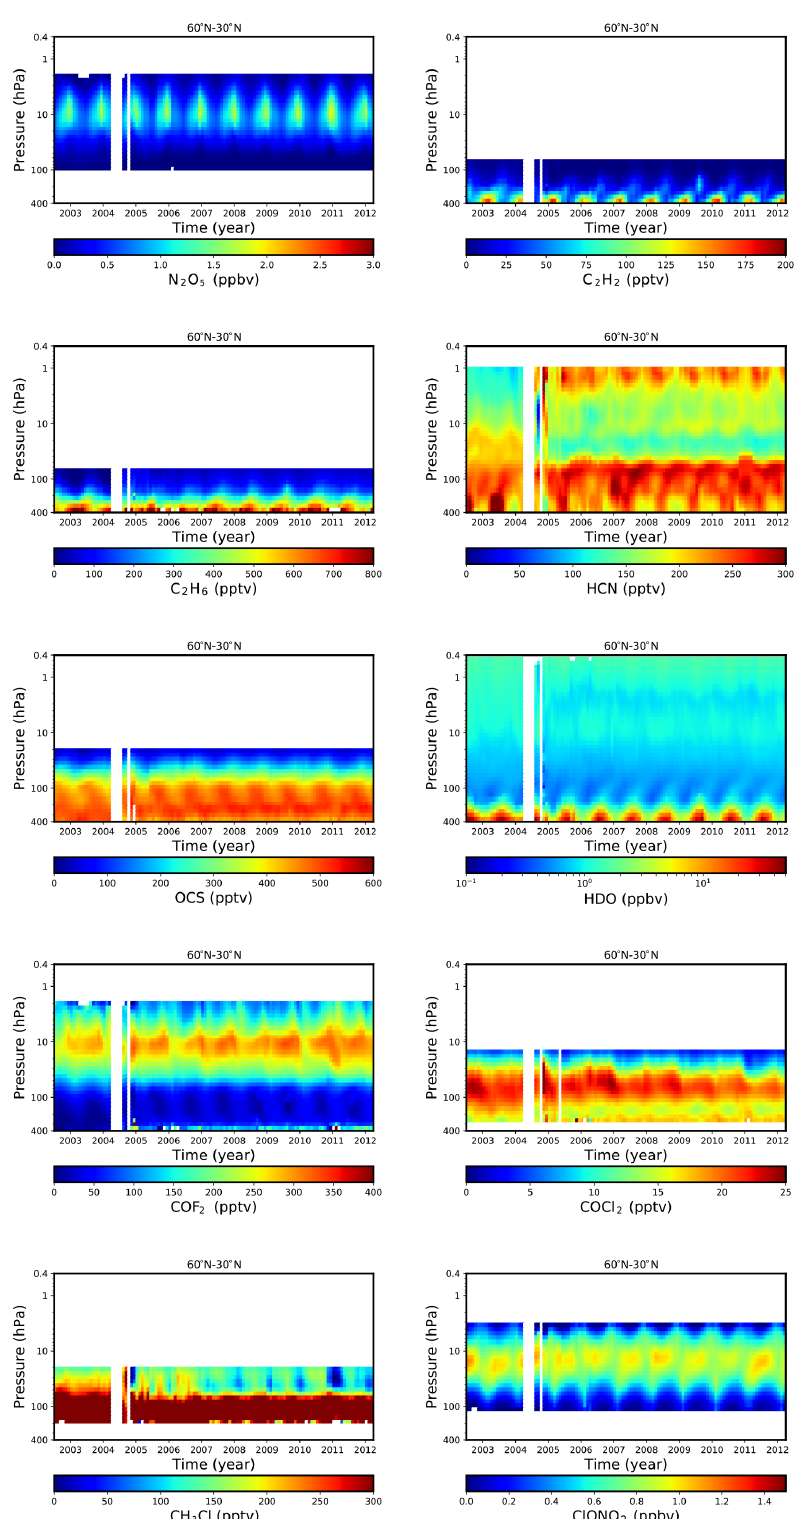
Figure 15. Time series of MIPAS level2-v8 database “new” species in the northern midlatitude region. Each species is plotted over its “useful” vertical range. While the time and pressure ranges are the same in each map, the colour scale (reported below each of them) is species